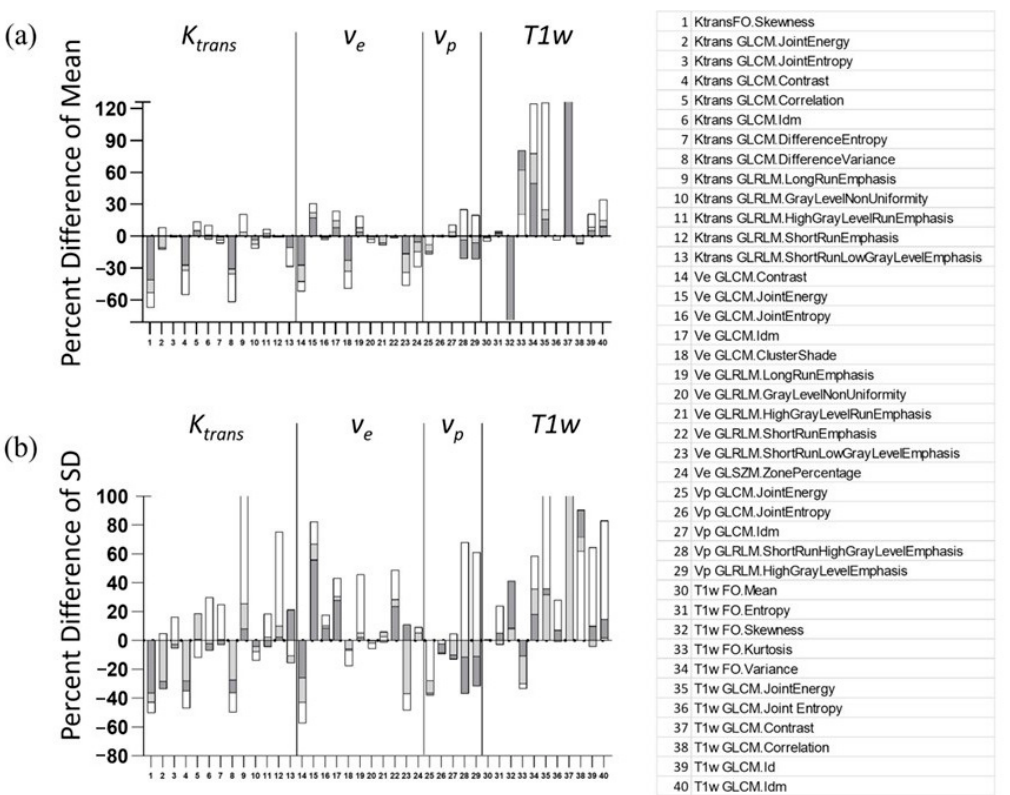
Figure 7. Bar plots representing the percent difference of the means ( a ) and standard deviations ( b ) of the 40 features used in recent studies listed in Table 1 show the difference between isotropic and up-sampled anisotropic images. The number of features with mean values differing by more than ±10% are 22, 24, and 32 for slice thicknesses of 0.234 mm (dark gray), 0.546 mm (light gray), and 1.014 mm (white), respectively. The number of features with SD values >10% is 22, 23, and 32, respectively. The percent difference of mean fell outside of the axis range for T1-w FO skewness ( − 217%, − 268%, and − 275%) and T1-w GLCM Contrast (165%,194%, and 253%). The percent difference of SD fell outside of the axis range for Ktrans GLRLM Long Run Emphasis (8%, 25%, and 196%), T1-w FO Variance (36%, 31%, and 375%) and T1-w GLCM Contrast (187%, 151%, and 232%).